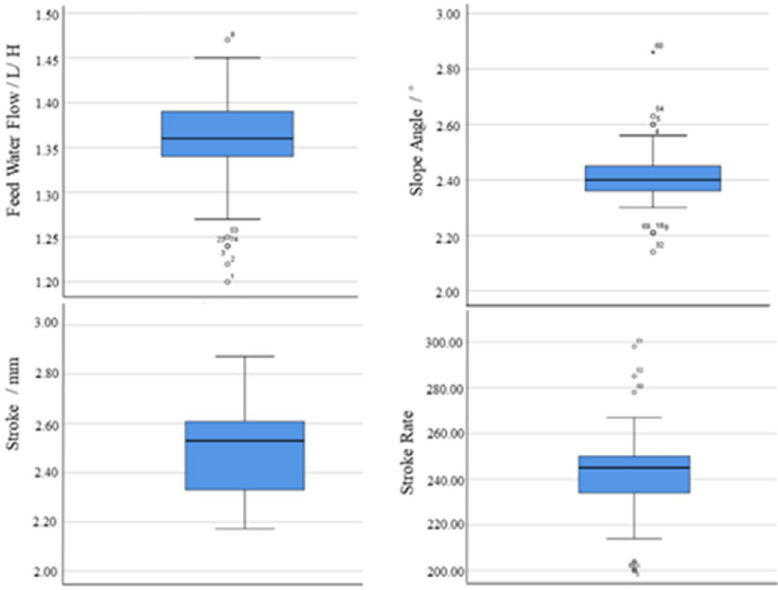
Figure 3. Abnormal analysis of control parameter values.